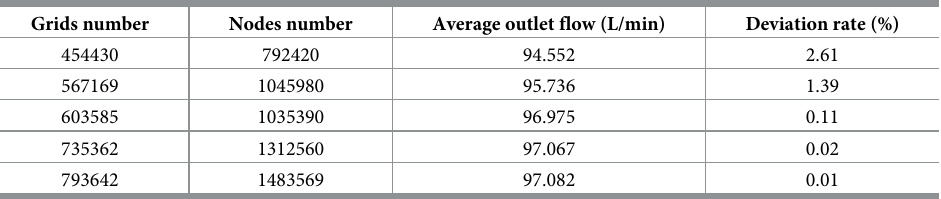
Table 5. Simulation results corresponding to different nodes numbers.